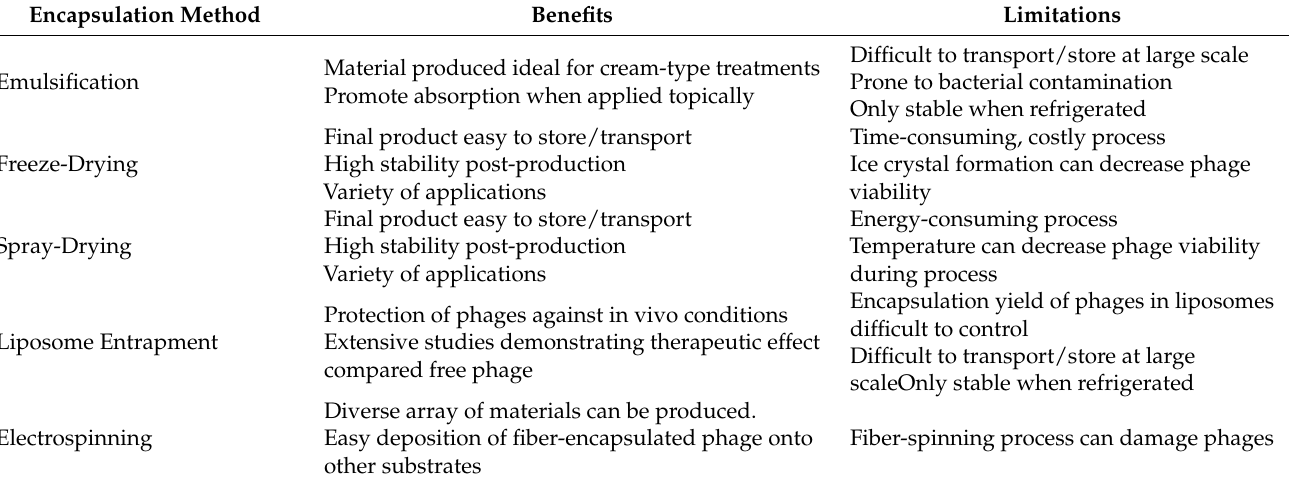
Table 2. Summary of the benefits and limitations associated with the mass production of encapsulated therapeutic phage